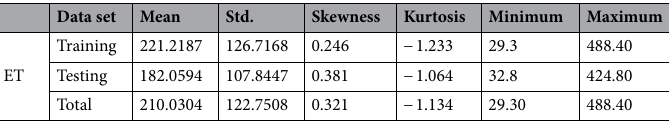
Table 1. The statistical characters of the monthly ET time series.